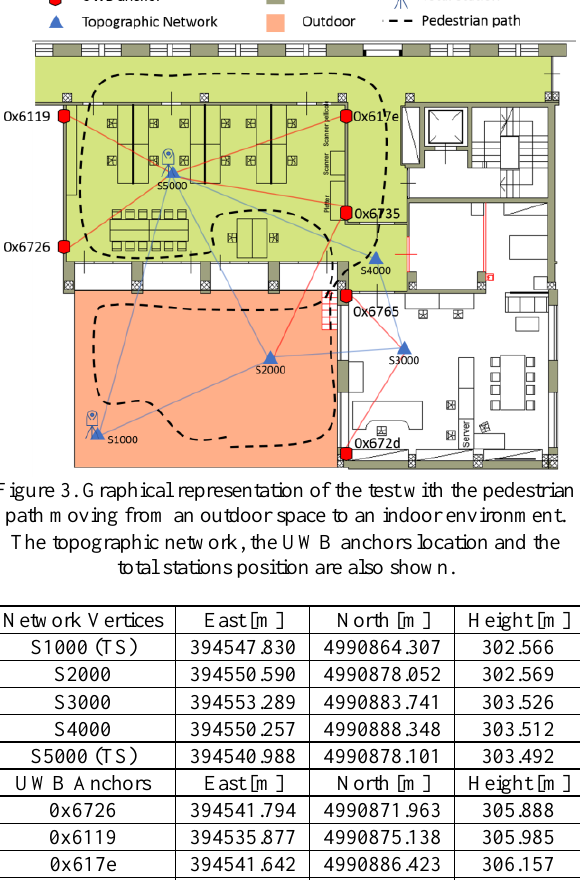
Figure 4. 3D point cloud of the environment. The blue area represents outdoor space where GNSS is available, the green area is the indoor environment covered by the UWB network, Table 2. Coordinates of georeferenced topographic network and while the red one is the indoor space outside the UWB UWB anchors in UTM-WGS84 32N.